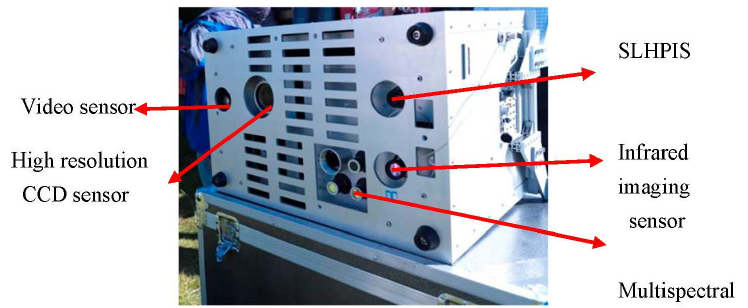
Figure 2. “LanTianHao” EOPS.